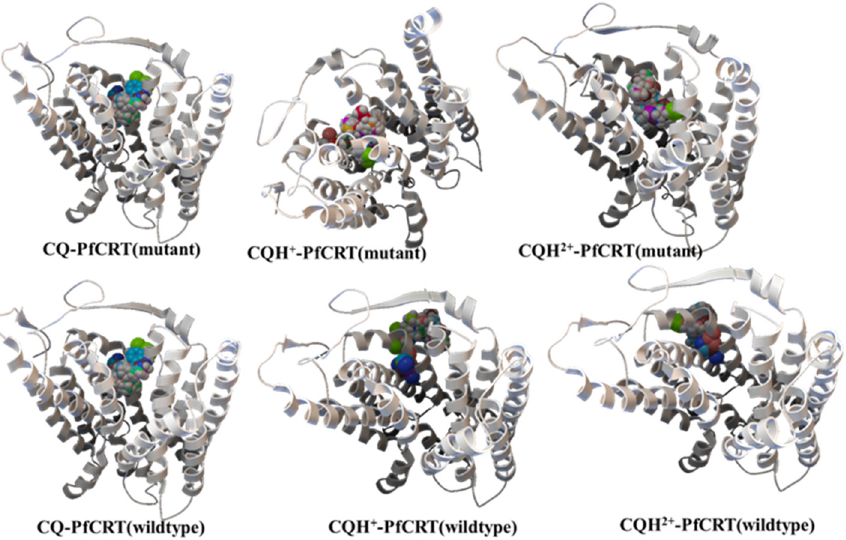
Table 3. Docking energy of neutral and protonated CQ to PfCRT models .